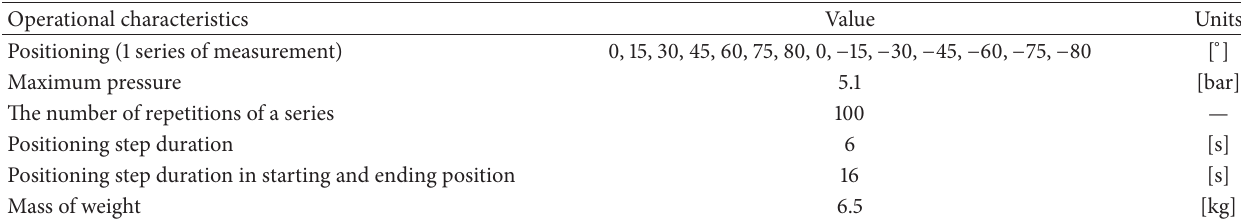
Table 3: The values of the operational parameters for the experimental measurement number